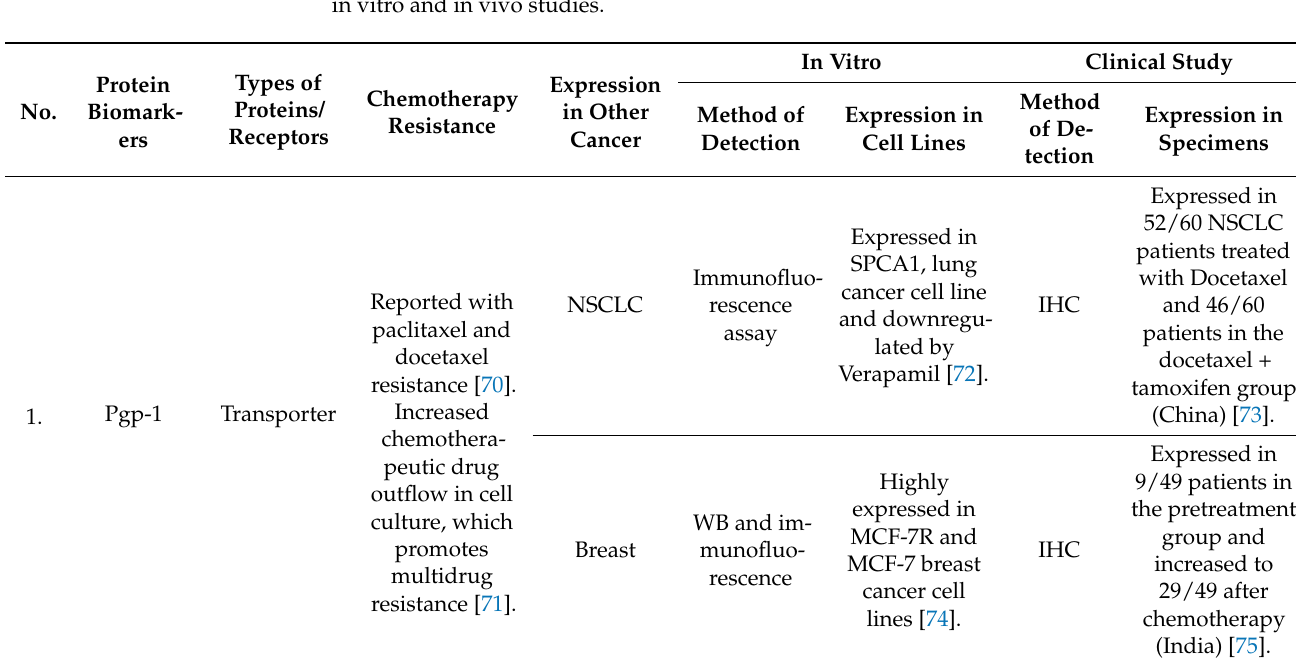
Table 3. The expression of the proposed membrane protein biomarkers in other cancer based on in vitro and in vivo